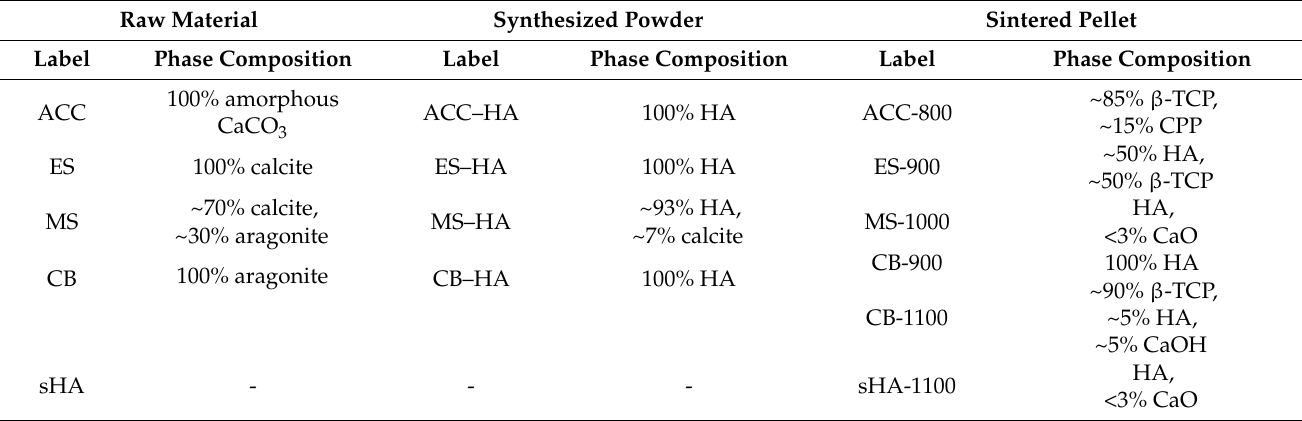
Figure 1. XRD spectra of the ( a ) raw materials and ( b ) synthesized powders. Table 2. The phase composition (wt%) of the raw materials, synthesized powders and sintered pellets determined with Rietveld analyses.